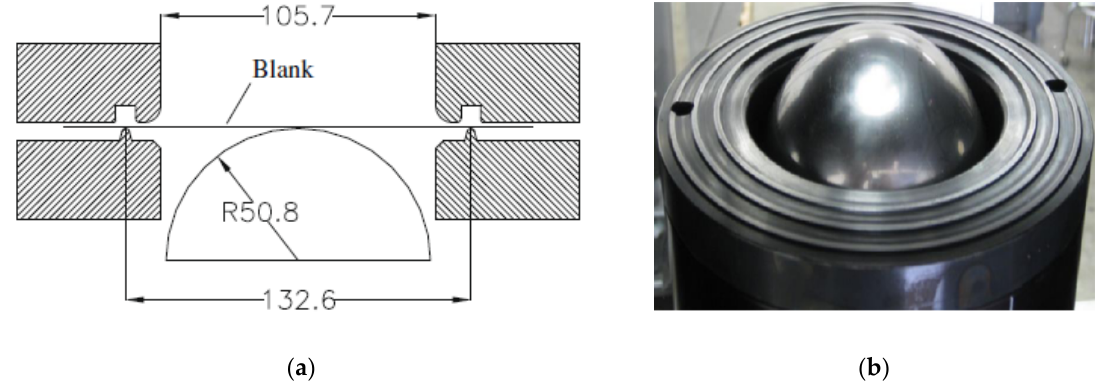
Figure 1. Schematic diagram ( a ) (Unit: mm) and punch and lower clamp of LDH test ( b ). The ARAMIS digital image correlation (DIC) system (GOM, Braunschweig, Germany) was used to accurately record and measure the deformation and strain of the TWB during